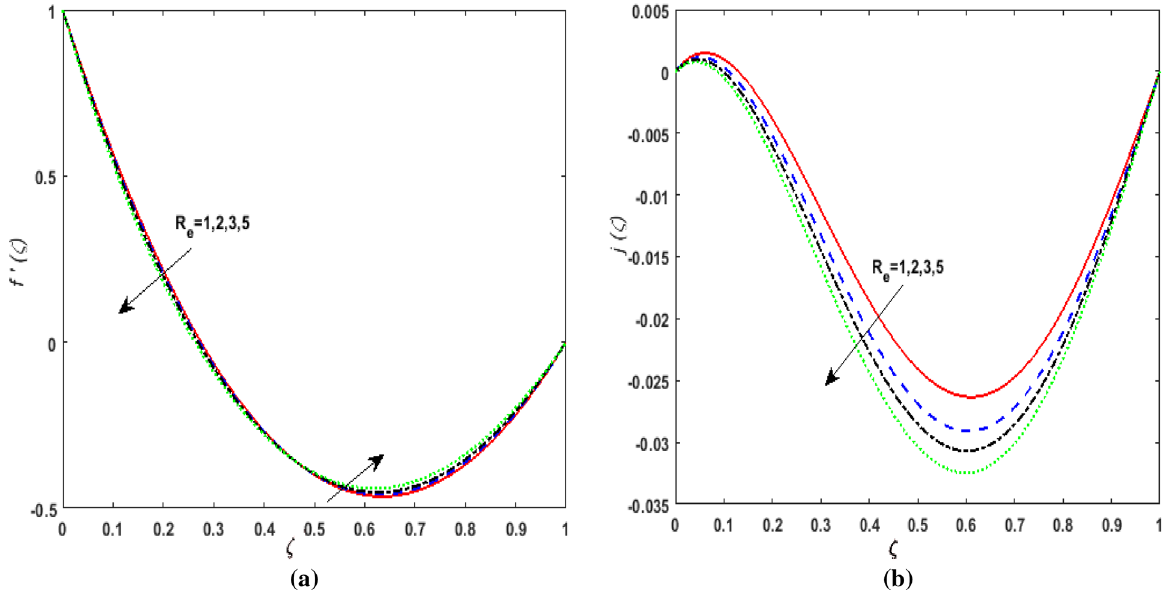
Figure 5. ( a ) Effect of Reynold number R e on velocity f ′ (ζ) . ( b ) Effect of Reynold number R e on velocity.